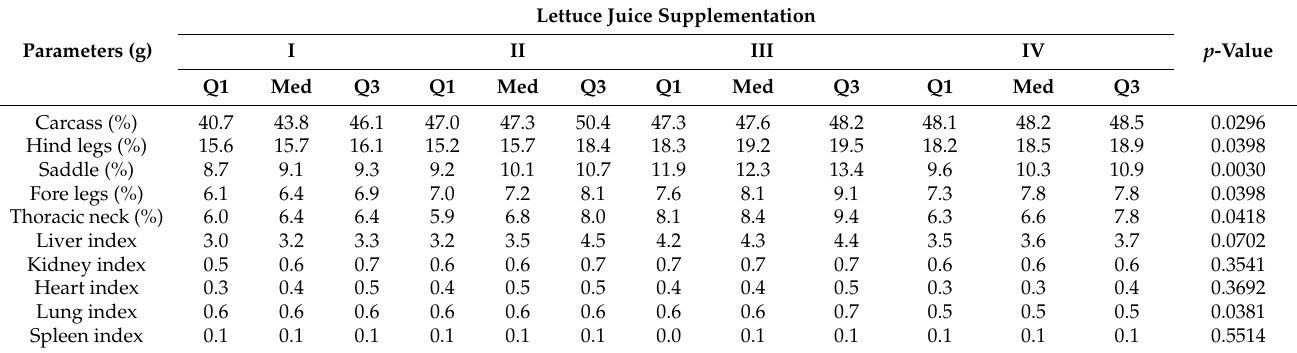
Table 6. Median (Med), first, and third quartile (Q1 and Q3) for relative weights of carcass cuts and internal organs of weaned V-line rabbits administered nitrate- or WPH-fertilized lettuce juice (10 mL/animal/day) as compared to that of nonfertilized lettuce or lettuce-free diet (groups I and II, respectively).